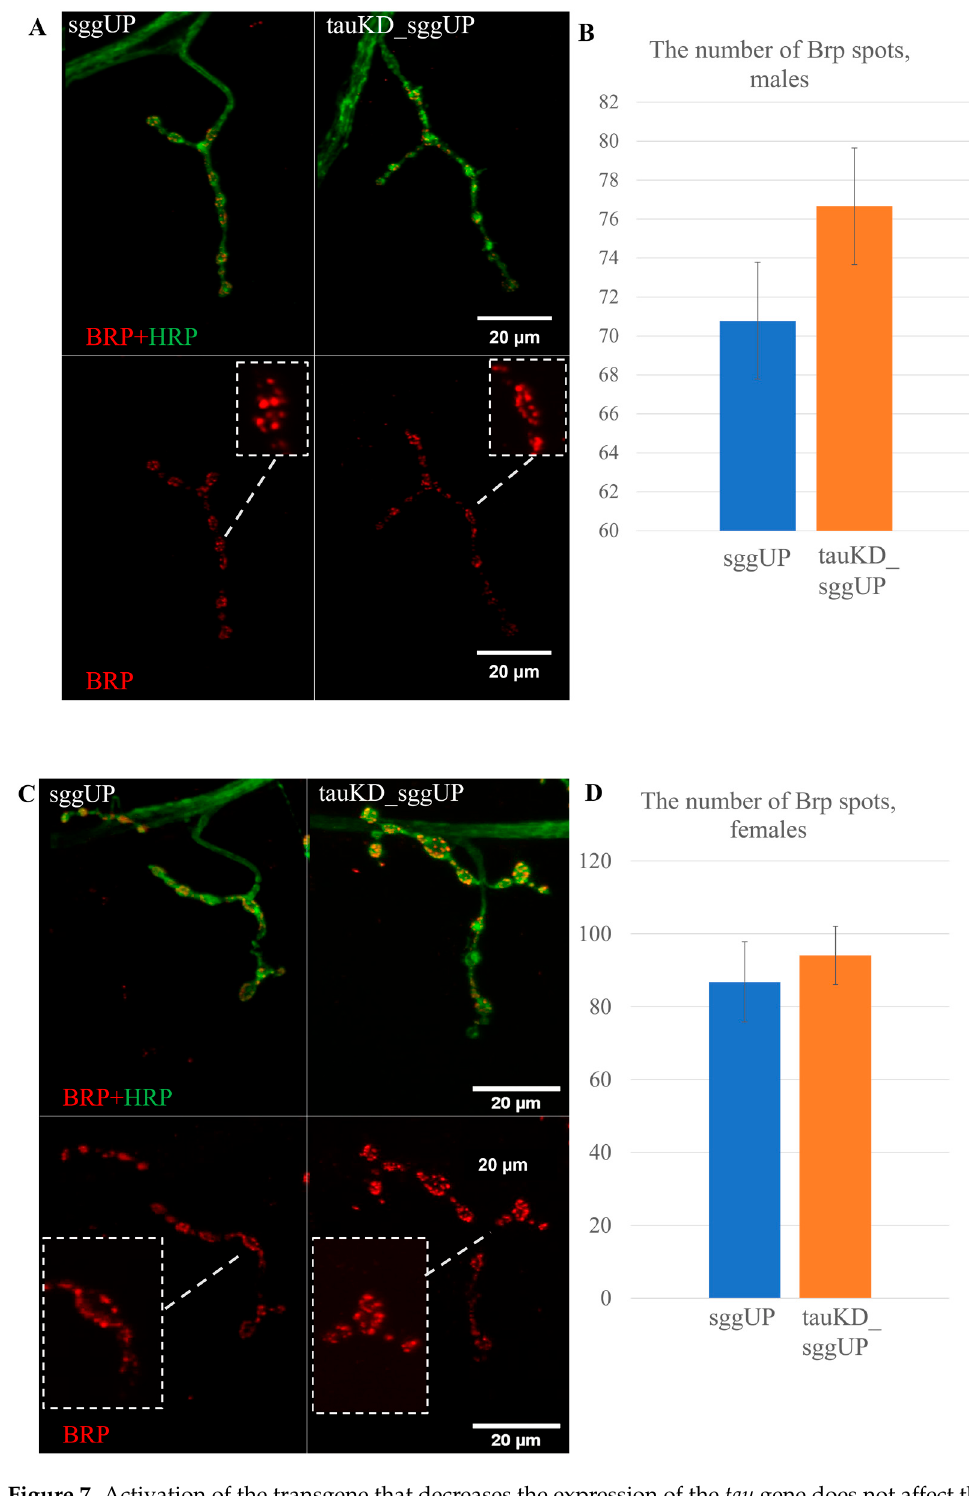
Figure 7. Activation of the transgene that decreases the expression of the tau gene does not affect the number of Brp spots in synaptic contacts reduced by the activation of the transgene that increases the expression of the RB transcript of the shaggy gene. ( A , B )—Immunostaining and the mean number of Brp spots in males. ( C , D )—Immunostaining and the mean number of Brp spots in females. A detailed description of the genotypes is given in the Materials and Methods section.